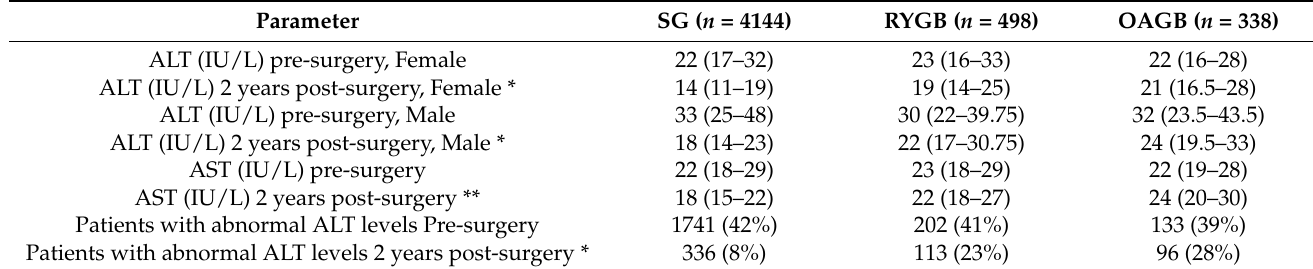
Table 1. Pre- and two-year post-surgery outcomes for the three surgery types in the study population. Parameter SG ( n = 4144) RYGB ( n =